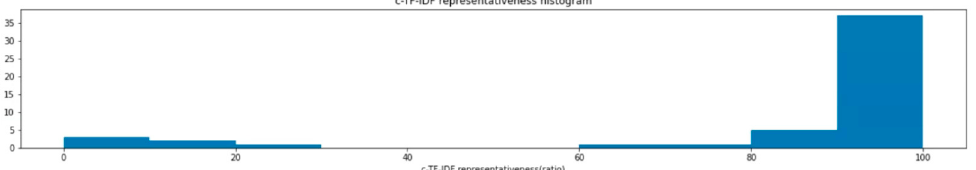
Figure 5. Histogram of c-TF-IDF representativeness ratio. The X-axis represents the c-TF-IDF representativeness as a ratio, and the y-axis represents how many topics have specific values of c-TF-IDF representativeness. For example, if c-TF-IDF representativeness is 90%, it means that approximately 90% of questions in a cluster could be explained by words with top 10 c-TF-IDF value.